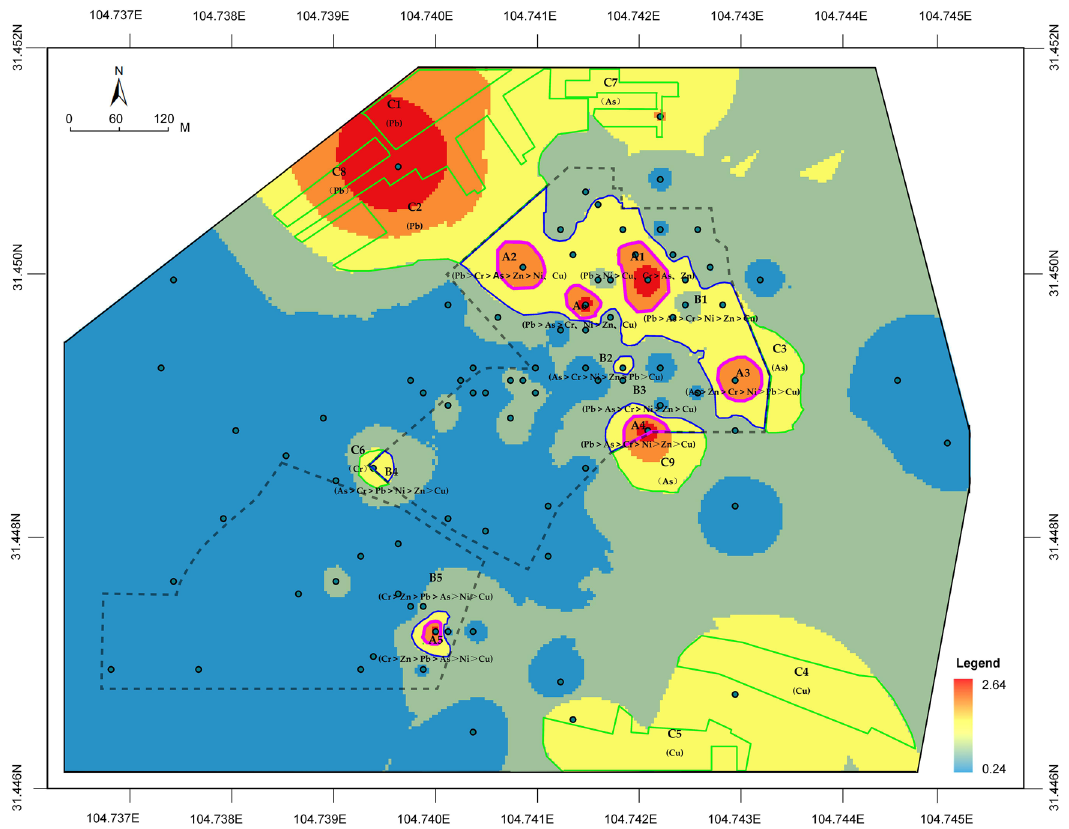
Figure 5. Spatial distribution of non-carcinogenic risk: a color range from blue across yellow to red represented a scale of low to high health risks. (Note: ArcGIS, Version 10.3, ESRI was used to create the map in this